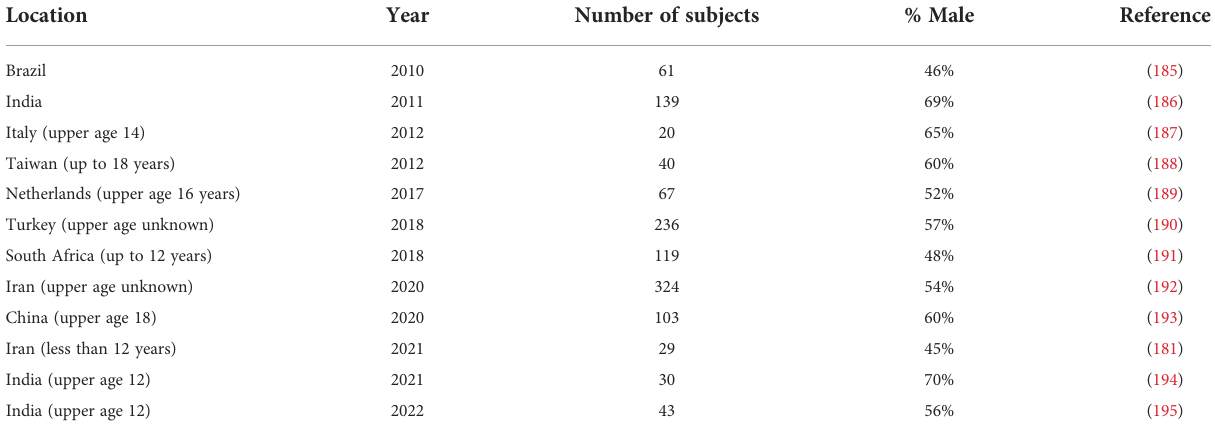
TABLE 5 Percentage of males in childhood GBS series of 20 or more cases since 2010.